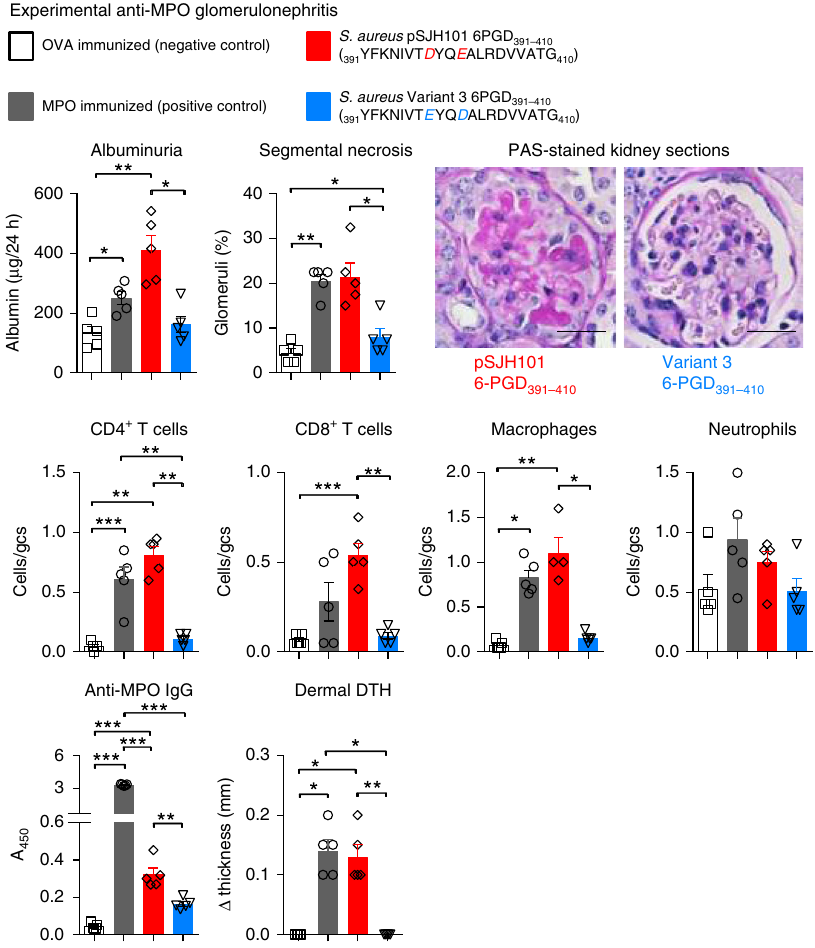
Fig. 7 Experimental anti-MPO glomerulonephritis in S. aureus pSJH101 6PGD 391 – 410 immunized mice. C57BL/6 mice ( n = 5 each group) were immunized with either OVA (negative control), MPO (positive control), S. aureus pSJH101 6PGD 391 – 410 or the common S. aureus 6PGD 391 – 410 variant, Variant 3. Low- dose heterologous anti-basement membrane globulin was injected intravenously to induce transient neutrophil recruitment and MPO deposition in glomeruli. Glomerular injury was measured by albuminuria, and by glomerular segmental necrosis on periodic acid-Schiff (PAS) stained kidney sections. Photomicrographs glomeruli from S. aureus pSJH101 6PGD 391 – 410 or S. aureus Variant 3 6PGD 391 – 410 immunized mice. In fl ammatory cells within glomeruli were enumerated and expressed as cells per glomerular cross section (gcs). Anti-MPO autoreactivity determined by detection of anti-MPO IgG by ELISA and dermal delayed type hypersensitivity (DTH) swelling after recombinant mouse MPO intradermal challenge. Scale bar is 30 μ m. Error bars represent the mean ± s.e.m. * P < 0.05, ** P < 0.01, *** P < 0.001 by Kruskal – Wallis test. Source data are provided as a Source Data fi